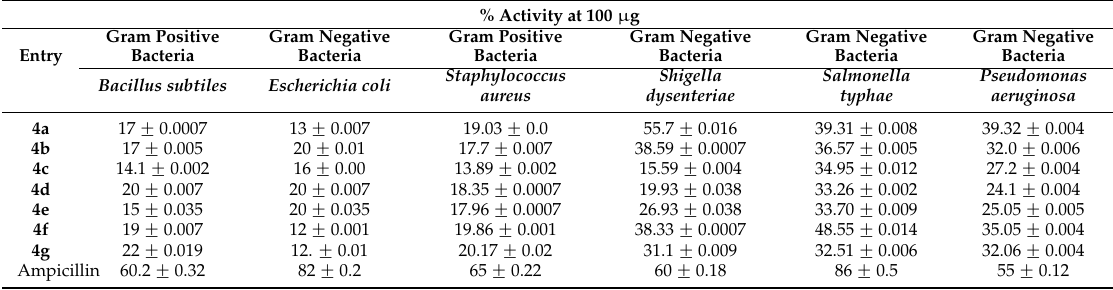
Table 7. Antibacterial activities (100 µ g) of 5-arylthiophene-2-sulfonylacetamide 4a – g . % Activity at 100 µ g